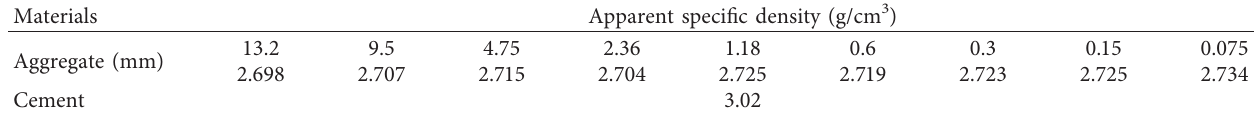
Table 2: Density of each material.